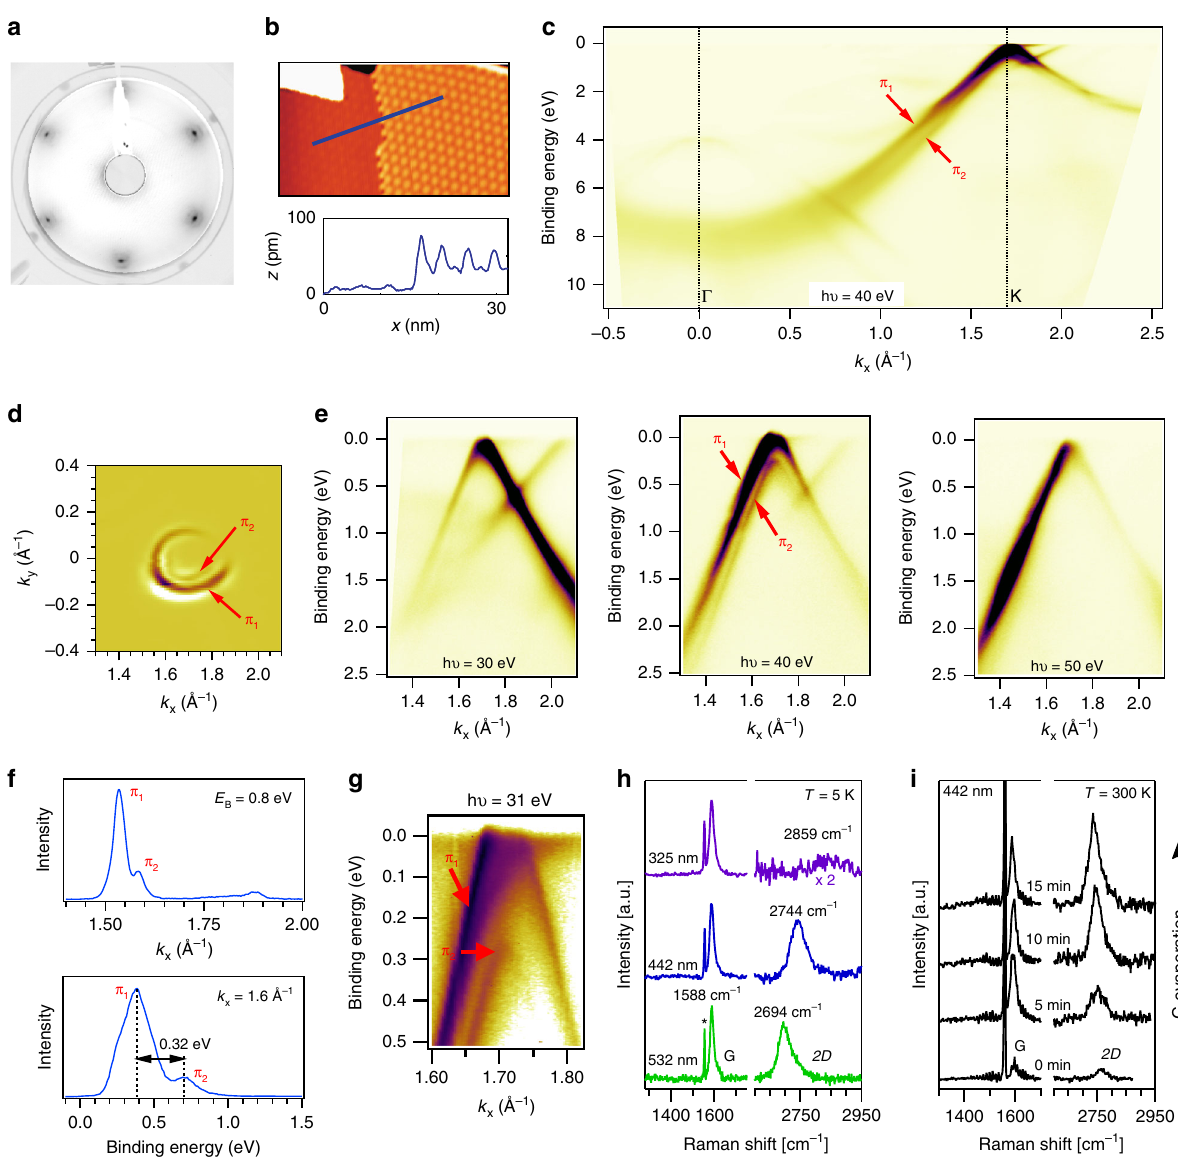
Fig. 1 Characterization of bilayer graphene/Ir(111). a LEED pattern ( E = 98 eV and T = 20 K) and b upper panel: STM topograph taken at 300 K over monolayer (left) and bilayer (right) graphene on Ir(111). Lower panel: height pro fi le along blue line in STM topograph. c ARPES scan along the Γ KM direction of the fi rst Brillouin zone (BZ). Labels π 1 and π 2 indicate the two π valence bands. d ARPES map composed of second derivative images at a constant binding energy E B = 0.7 eV as a function of 2D wavevector. e ARPES scans along the Γ K direction for three different values of h ν as indicated. f Momentum distribution curve (top) and energy distribution curve (bottom) for the h ν = 40 eV ARPES scan of e . c – f are measured with circularly polarized light at T = 70 K. g ARPES scan taken with linearly p polarized light at h ν = 31 eV and T = 15 K measured along the Γ K direction. h Ultra-high vacuum (UHV) Raman spectra of bilayer graphene grown in one step for three laser excitations as indicated. The G and 2D modes are indicated and the feature at 1550 cm − 1 denoted by ‘ *' is due to O 2 in the laser path outside the UHV chamber. i UHV Raman spectra of initial stages of bilayer growth during step-by-step carbon deposition onto monolayer graphene, i.e., the sample was cooled to room temperature after each C evaporation an analysis of the two π bands from the ARPES spectrum of bands are visible. The visibility of the second band in these bilayer graphene measured at h ν = 40 eV. In the upper panel of conditions can be explained by the different photon energy and Fig. 1f, a momentum dispersion curve is shown. The two indi- polarization used, as well as by the better resolution set for these cated peaks correspond to the π bands. In the lower panel an measurements 44 . energy distribution curve close to the K point is shown. Two peaks that are split by Δ E = 0.32 eV can be observed. The split- displayed in Fig. 1h for three laser excitation wavelengths (532, ting is in reasonable agreement to tight-binding calculations with 442, and 325 nm). Raman spectroscopy has been performed after parameters fi t to graphite 42 and to ARPES experiments with bilayer graphene on SiC 43 which yield a splitting of ~0.4 eV. In Fig. 1g, we show an observation of the π band structure using h ν = 31 eV and linearly p polarized light. In these conditions, both π 2D bands show strong differences from the monolayer case